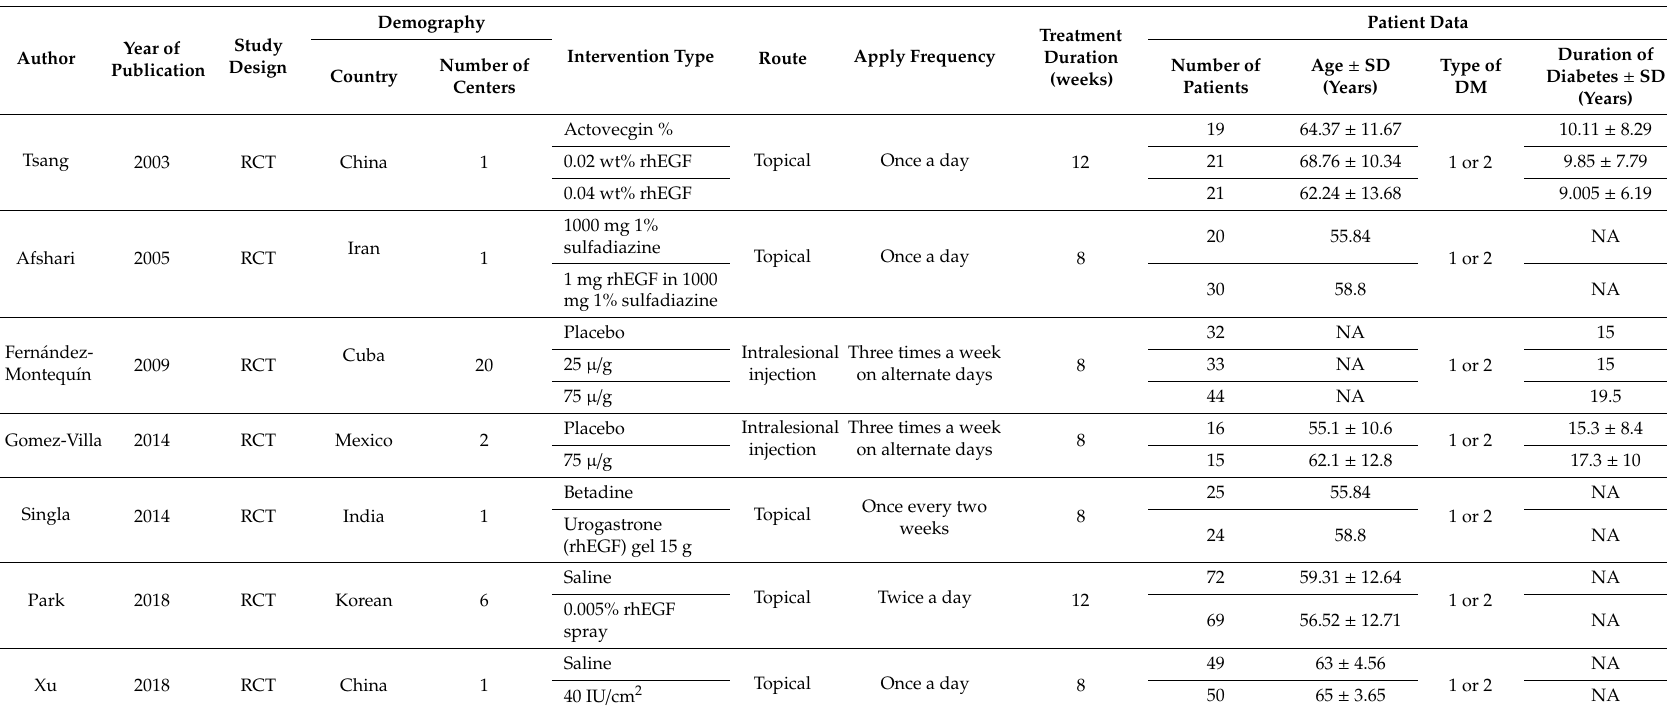
Table 1. Study and patient characteristics with the corresponding type of intervention, from studies included for meta-analysis (NA: not